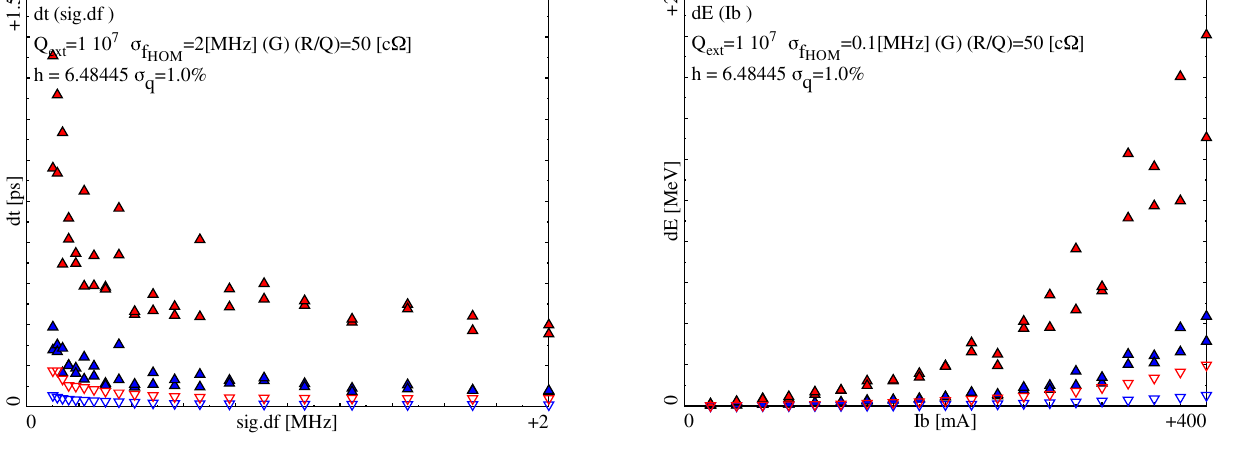
FIG. 30. (Color) dt as a function of (cid:1) (cid:3) f for two consecutive pulses with Q ext ¼ 10 7 , I b ¼ 400 mA ; red: worst bunch in pulse; blue: rms; filled upward triangles: with 1% charge scatter; hollow downward triangles: without bunch